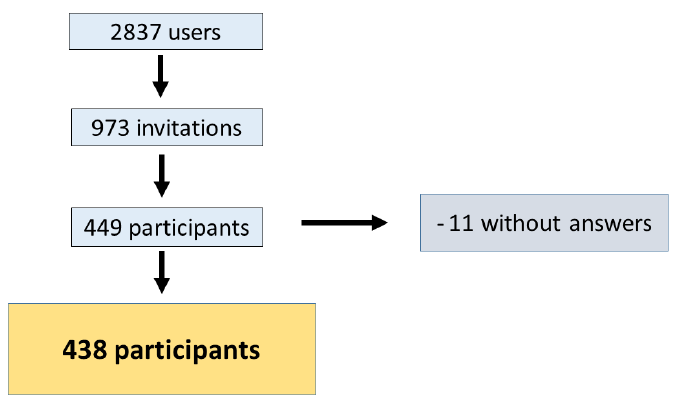
Figure 2. Data cleaning.